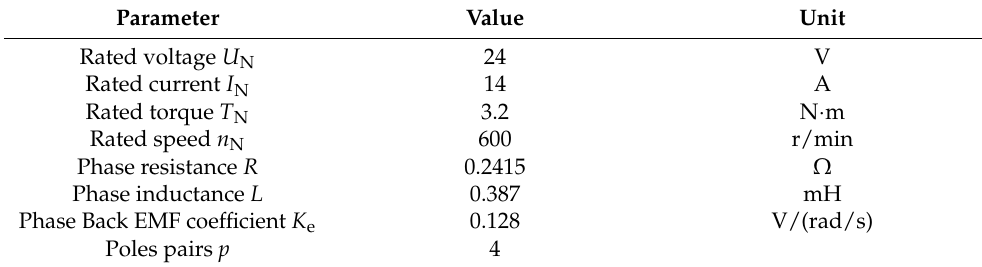
Table 3. Experimental motor parameters.